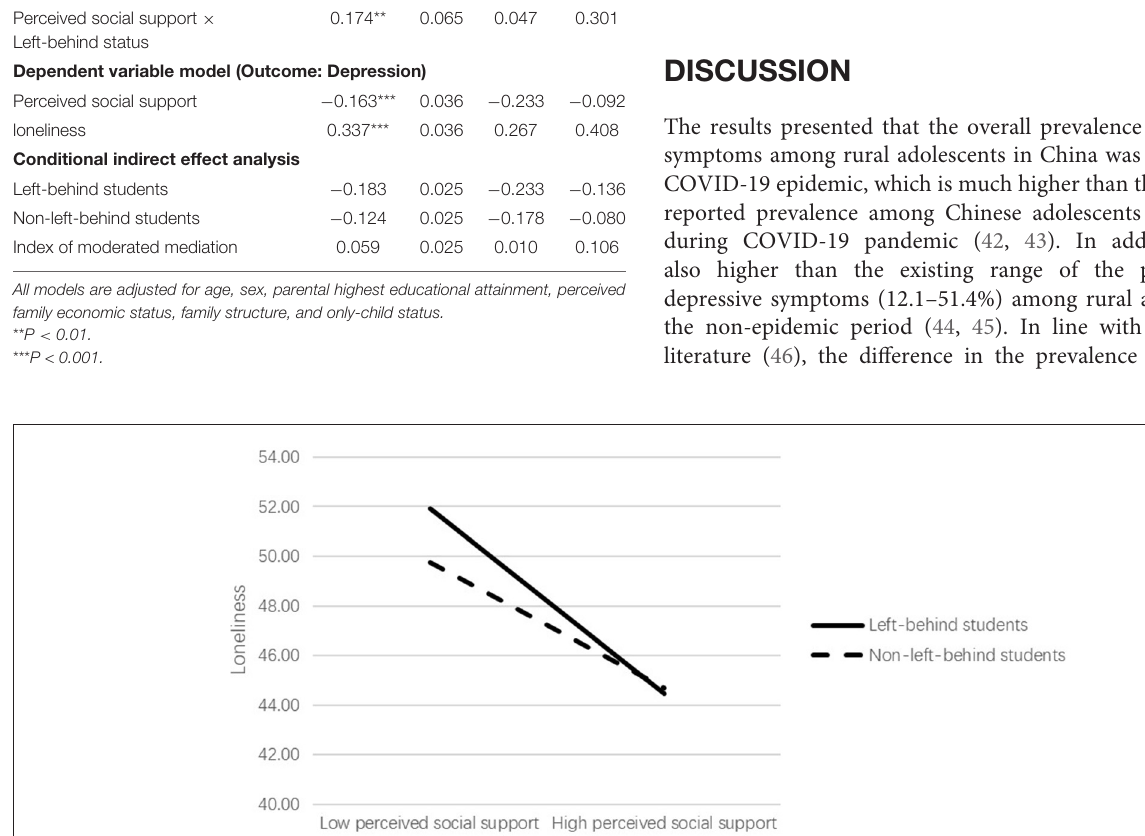
Frontiers in Psychiatry |